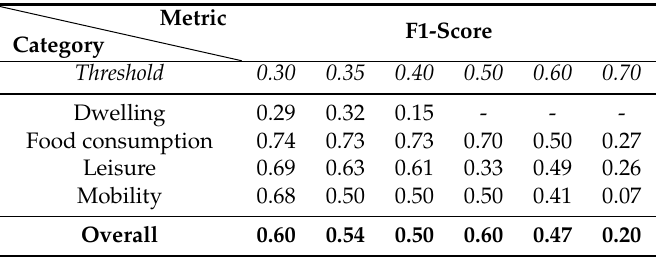
Table 9. The F1-score value for each energy-consuming activity category at varying level of threshold. The values for the Dwelling category for threshold greater than 0.4 are undefined because no posts were classified in that